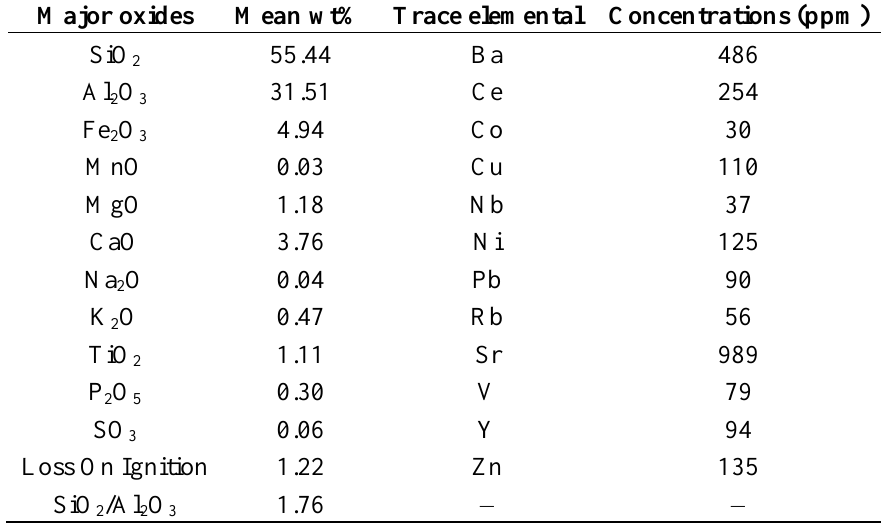
Table 1. X-ray fluorescence results of Arnot coal fly ash illustrating the quantities (wt%) of the major oxides and trace elements (ppm) of which it is